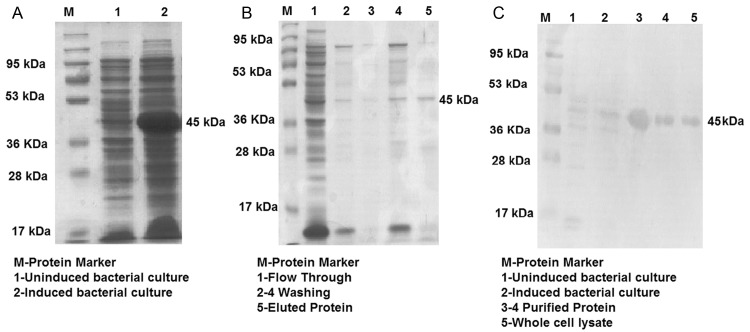
Expression of recombinant LdSir2RP in E. coli Rosetta strain and its purification.Expression and purification of rLdSir2RP (1A, IB) in prokaryotic cells, Whole Cell Lysate (WCL) of transformed E. coli separated on 12% acrylamide gel and stained with Coomassie blue, M: Molecular wt. markers; Lane 1: WCL before IPTG induction; lane 2: WCL after IPTG (1.0 mM) induction at 37°C. Lane 5: eluted protein (1B). Western blot analysis using anti-rLdSir2RPAb in uninduced WCL, induced WCL and SLD—M: Mol wt marker, Lane 1: uninduced WCL, Lane 2: induced WCL (1C).